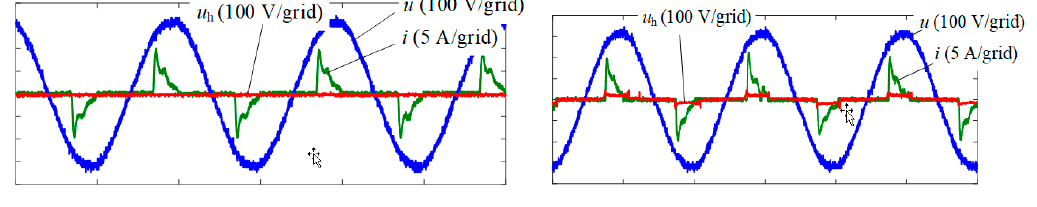
Figure 6. Test circuit of diode rectifier with capacitive filter and EMI filter.